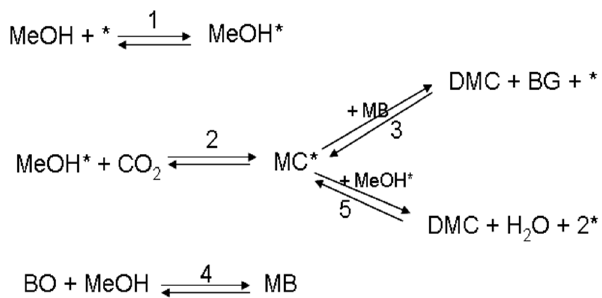
Figure 10. Reaction scheme for the synthesis of dimethyl carbonate (DMC).